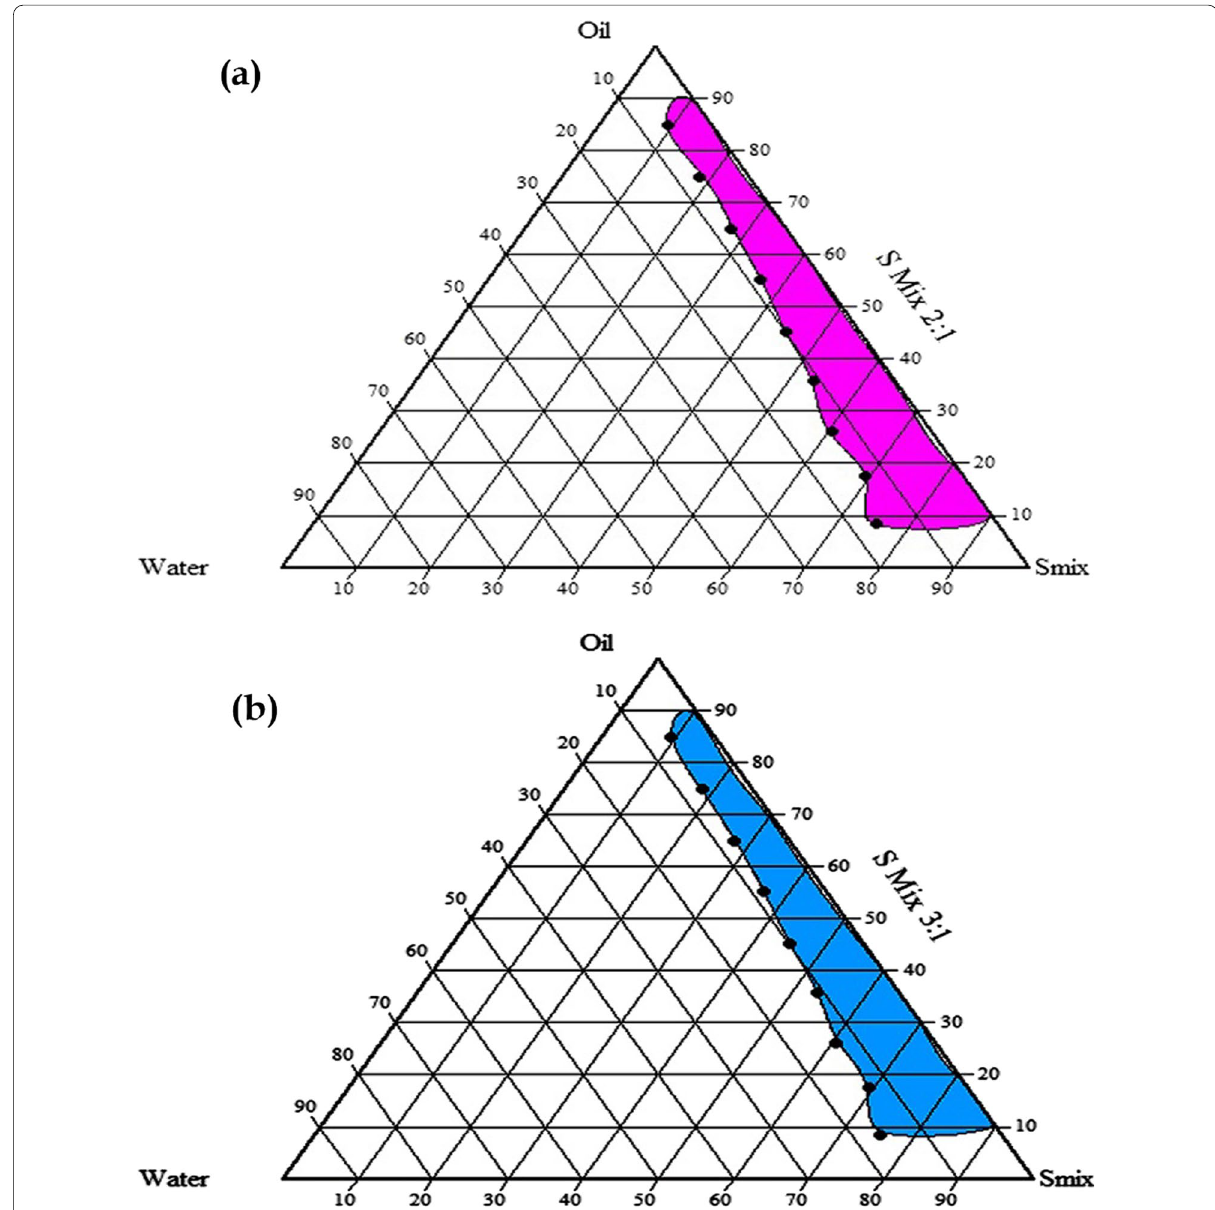
Fig. 1 Pseudoternary phase diagram of a capryol 90 with labrasol S mix 2:1emulsion area, b capryol 90 with labrasol S mix 3:1 emulsion area pseudoternary phase diagram (